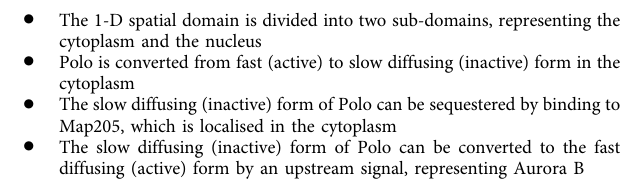
Spatial regulation of Polo Kinase: Models . Here we present the basic aspects of the models used for the exemplar cases (also see Supplementary Note 7). We examine two distinct intracellular contexts where experimental evidence shows that the localisation of a protein, Polo kinase/Polo like kinase plays a central role. The fi rst is in the transduction of cytoplasmic protein gradients that regulates polar- isation in the C. elegans zygote. The second involves nuclear localisation of Polo kinase triggering a mitotic switch, through a mechanism involving multiple pos- sible feedback interactions. Here we focus on a model suggested by experiments in Drosophila — however, we note that nuclear localisation of Polo and its role in the mitotic switch is observed across different organism 45 . Both these examples highlight multiple themes encountered in the paper: the effect of localisation, the presence of two diffusivity nodes, and consequences for inference as well as engineering design principles. We fi rst discuss the transduction of cytoplasmic protein gradients by PLK1 A cascade of intracellular protein gradients is established during asymmetric cell division in the C. elegans zygote 46 . The RNA binding protein Mex-5 forms a gradient, with higher levels in the anterior cytoplasm. This upstream gradient drives gradient formation in the Polo like kinase PLK-1. The PLK-1 gradient in turn drives gradient formation in the RNA binding protein Pos-1. Experimental evidence and modelling suggests that these gradients are formed by spatially graded interconversion between slow and fast diffusing forms of these proteins in each case 25